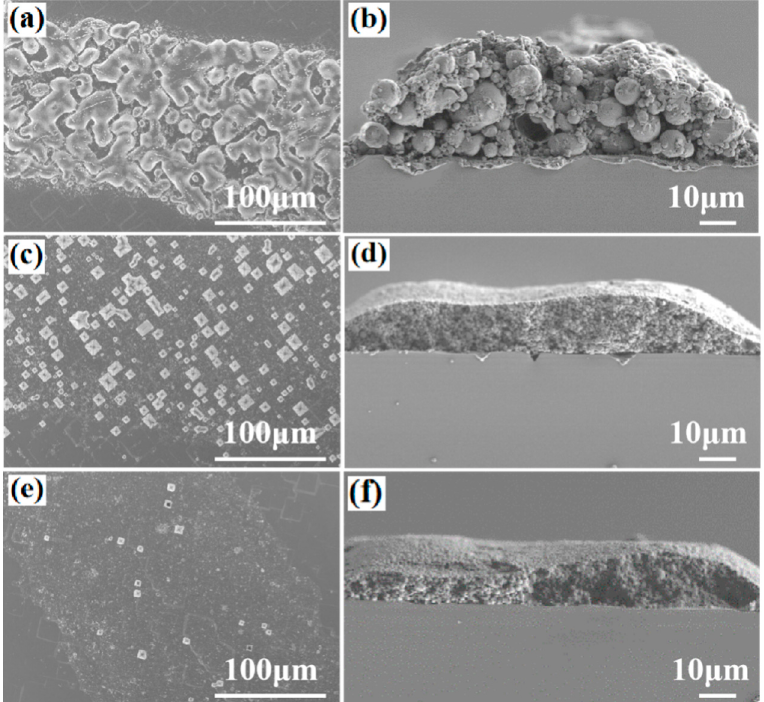
Figure 4. ( a ), ( c ), ( e ) Surface morphologies of cells with paste 1, 2, 4 after the contact pastes were etched away; ( b ), ( d ), ( f ) cross section of contact grid lines fabricated with paste 1, 2, 4.